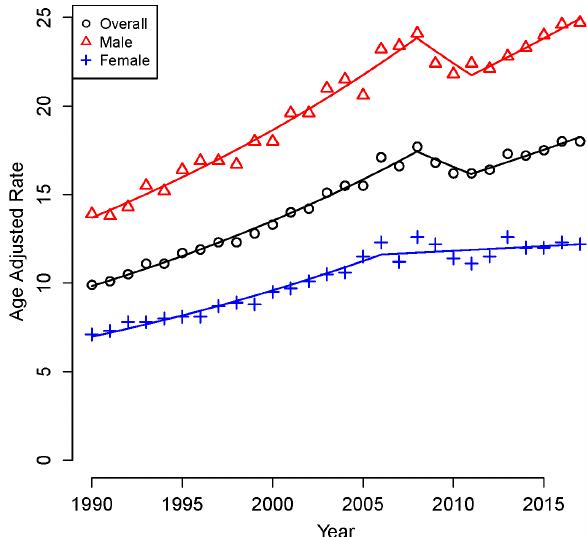
Figure 2: Gender-stratified, age-adjusted rates of RCC per 100,000 population, 1990–2017.